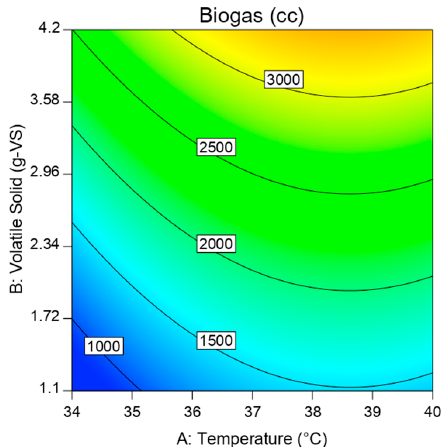
Figure 5. Contour plot views the effect of temperature and volatile solid on the Biogas volume at sludge quantity of 37.5%.